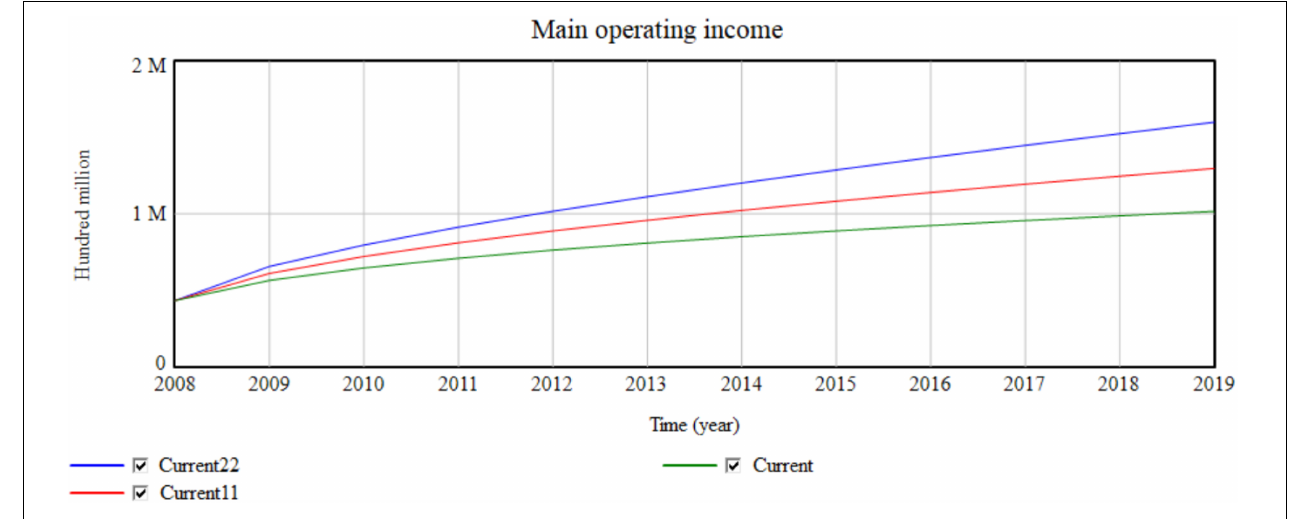
FIGURE 11 | Impact of the macro value network on the main operating income.